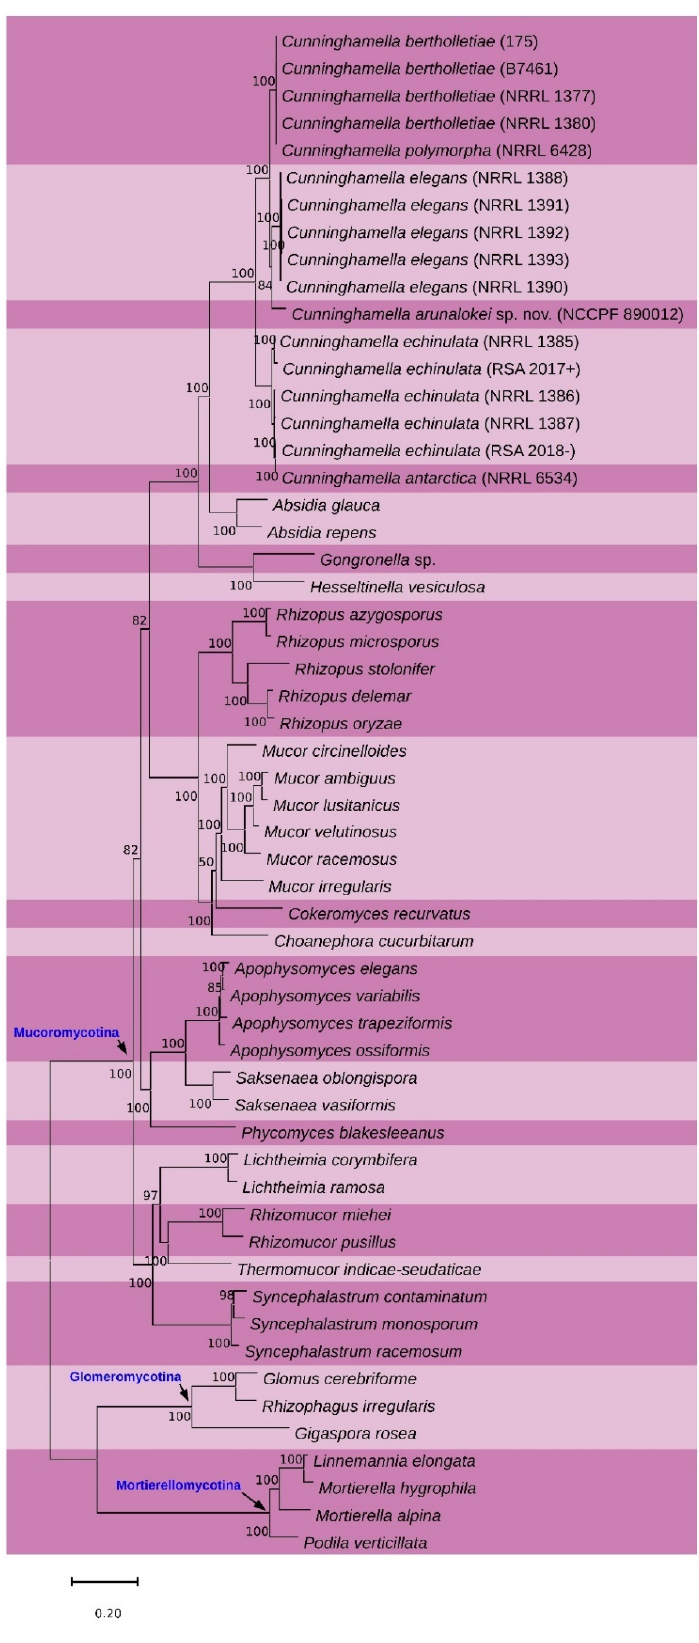
Figure 4. Whole genome phylogeny of Cunninghamella arunalokei.